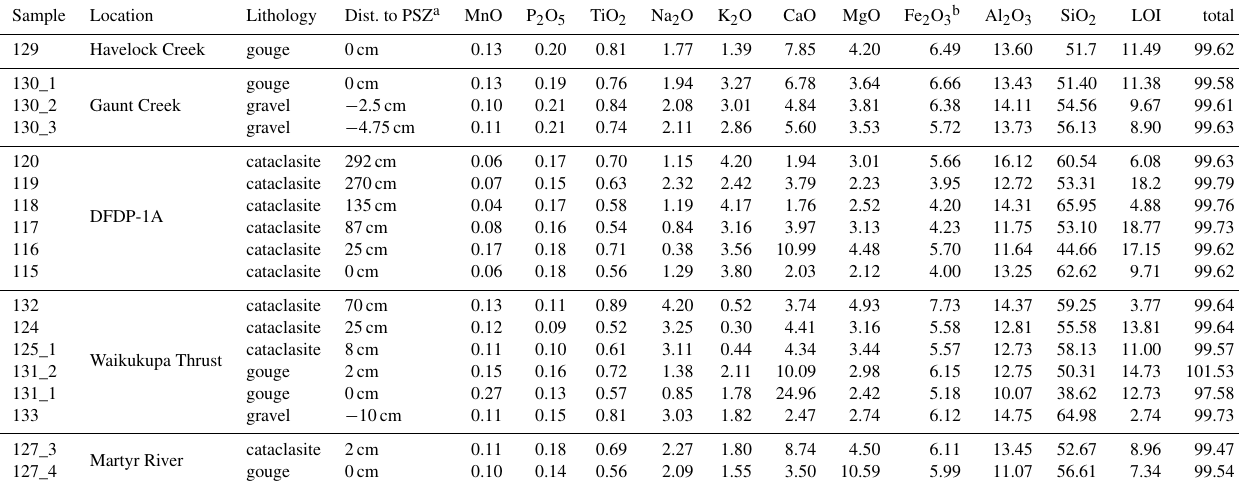
Table 5. Geochemical composition [wt%] of investigated samples as determined by XRF. Sample